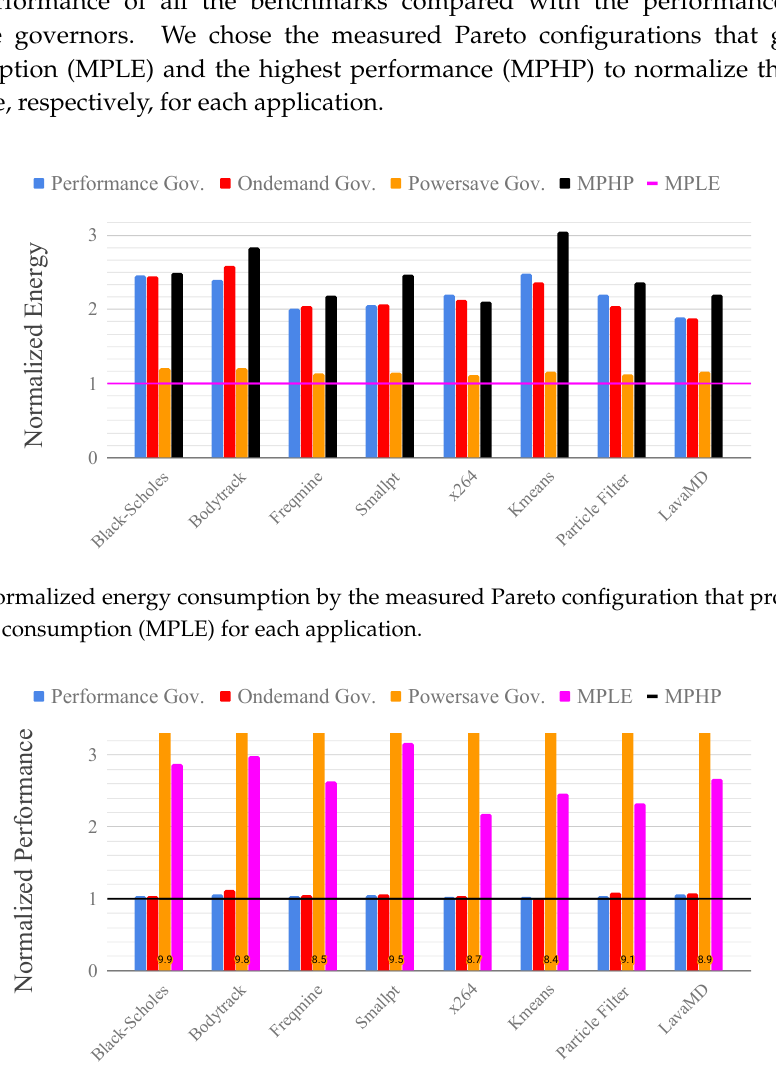
Figure 7. Normalized performance by the measured Pareto configuration that provides the highest performance (MPHP) for each